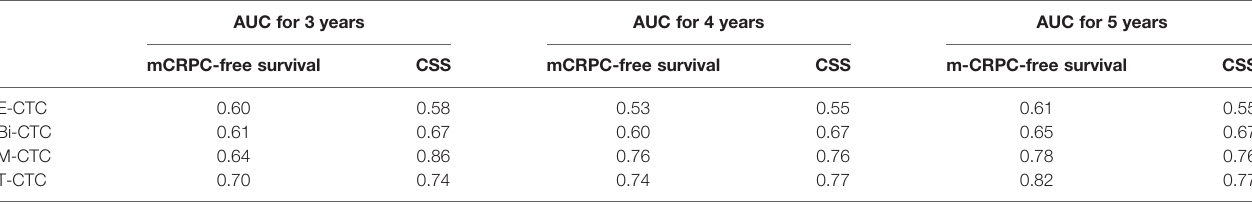
TABLE 4 | Comparison of predictive ef fi ciency among different CTC subtypes according to time ‐ dependent receiver operating characteristic curve analysis.